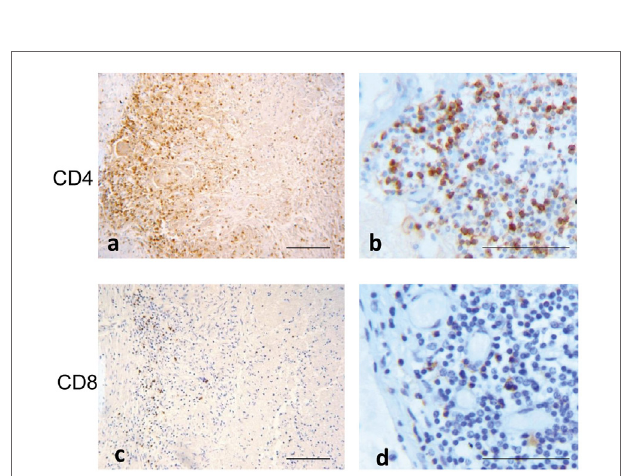
FigUre 4 | Lung tuberculosis (TB) histopathology and CXCL10 staining